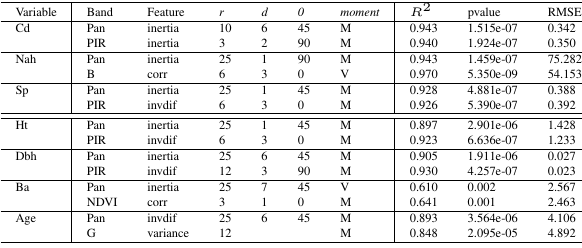
Table 3: Forest structure variables and their best image descriptors The best descriptors were found for density and crown diame- ter (which have the biggest impact on image texture) which are the Blue band correlation and the Pan inertia respectively. All other forest variables are well described except for the basal area.